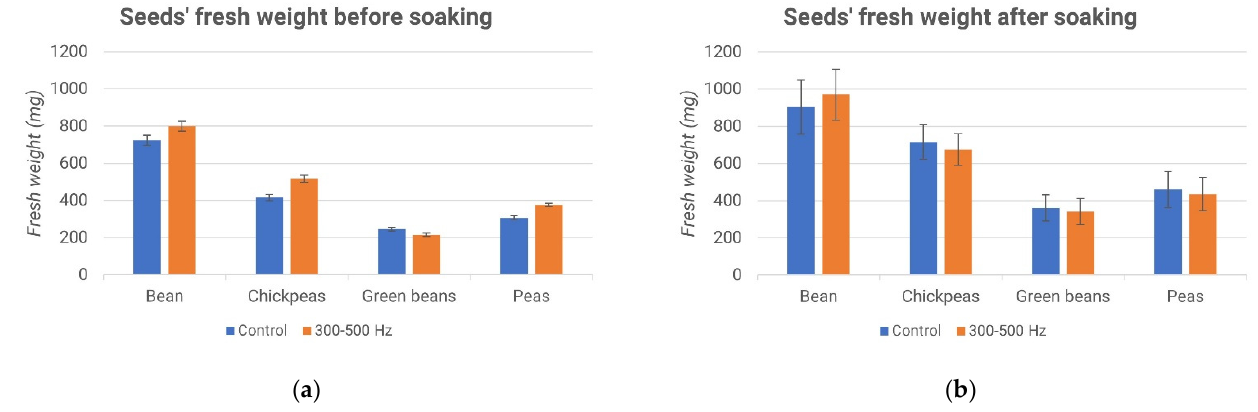
Figure 15. Seeds’ fresh weights before soaking ( a ) and after soaking ( b ).